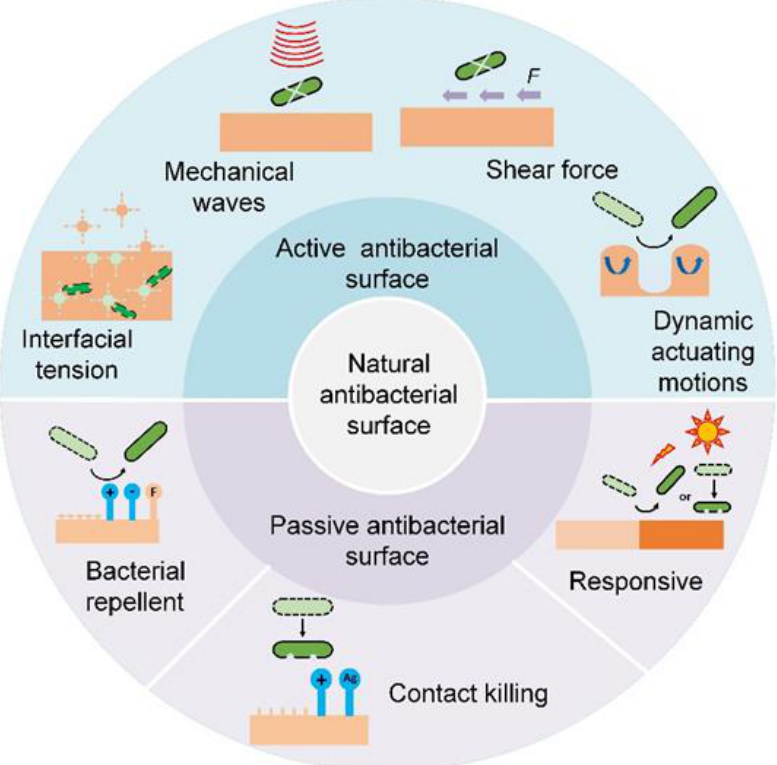
Figure 3. Scheme of nature and bioinspired antibacterial surfaces.